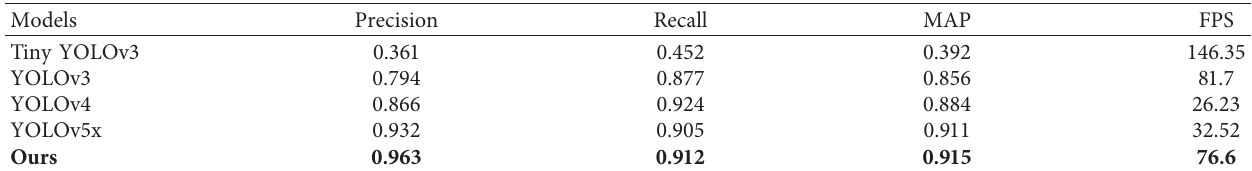
Table 6: Comparisons of experimental